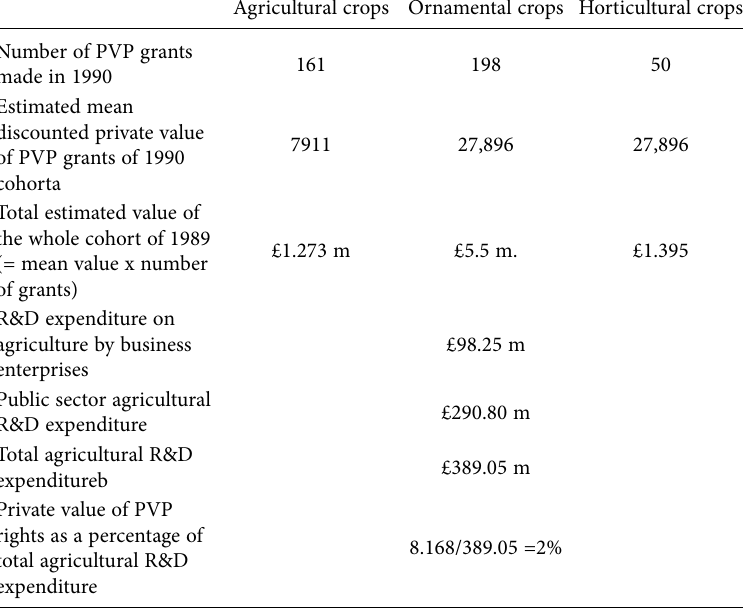
Table 9. Private Value of PVP Certificates and Agricultural R&D Expenditure Agricultural crops Ornamental crops Horticultural